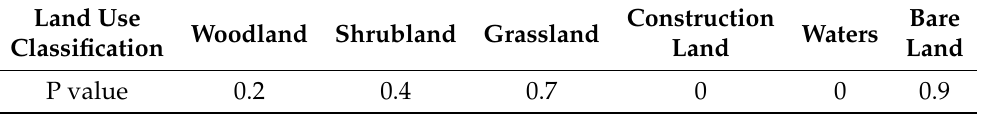
Table 2. P values of different land use types in the study